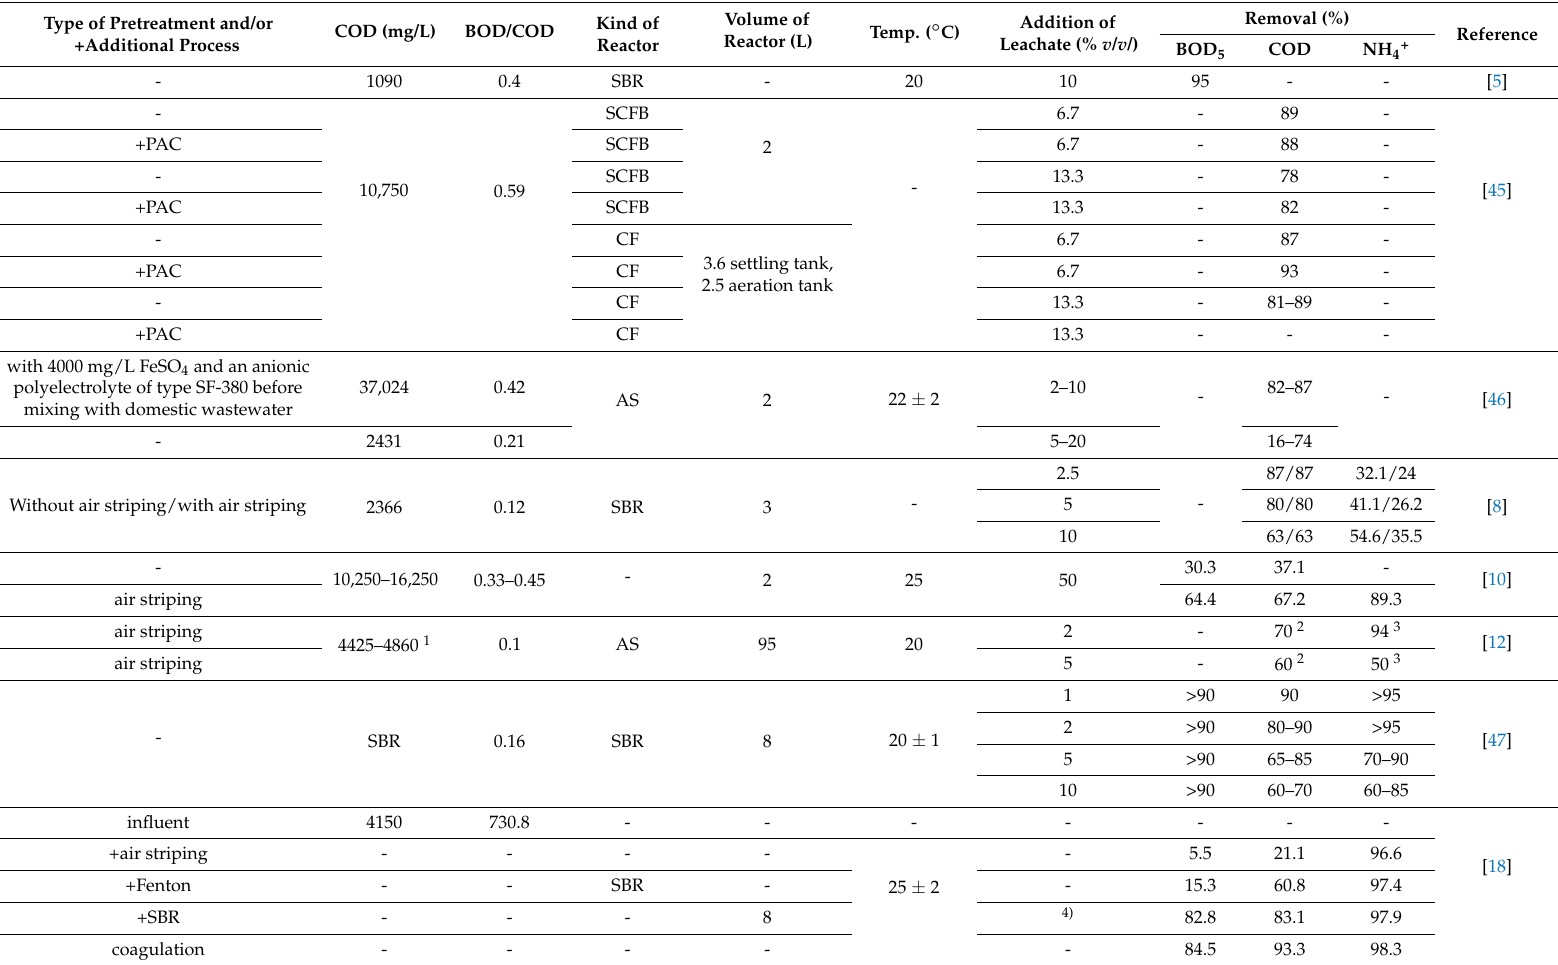
Table 9. Removal efficiency of selected indicators in co-treatment of leachate with